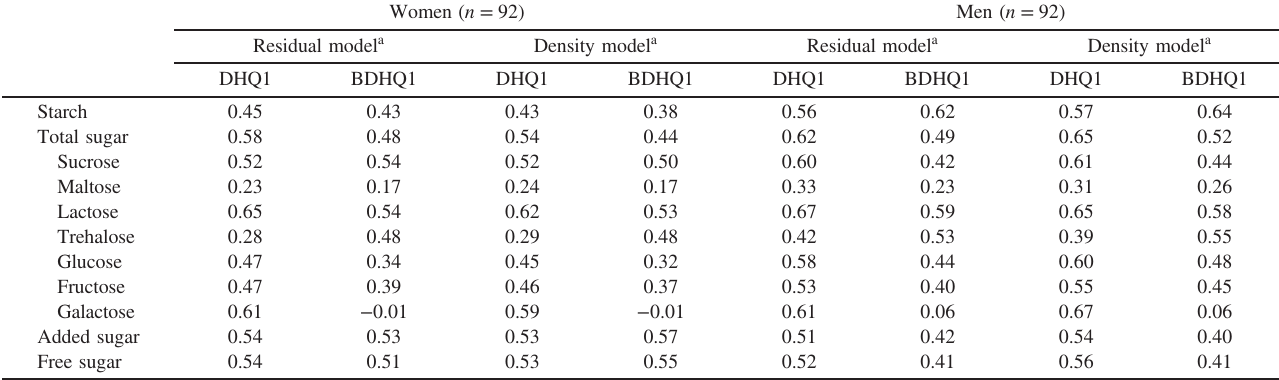
Table 4. Spearman correlation coe ffi cient between intake of starch and 10 types of sugars estimated using the 16-day DRs and that estimated using the DHQ1 and BDHQ1 among Japanese women and men Women ( n = 92) Men ( n = 92)